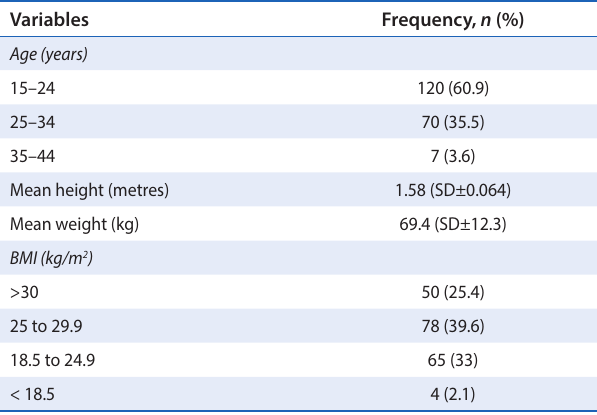
Table 1: Baseline characteristics of the pregnant women